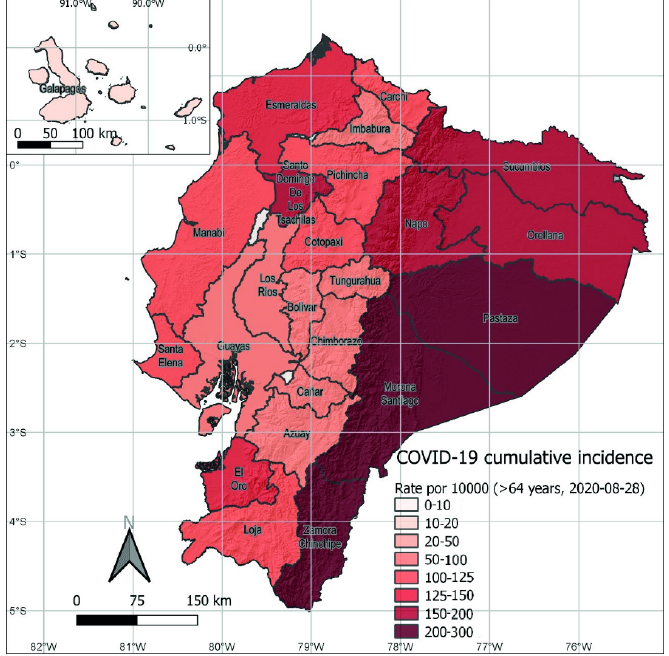
Figure 1. Cumulative incidence of COVID-19 cases adjusted for 100,000 inhabitants, by provinces in Ecuador, by August 2020. Table 1. Prevalence of COVID-19 cases (per 100,000 inhabitants) by province and age group, and